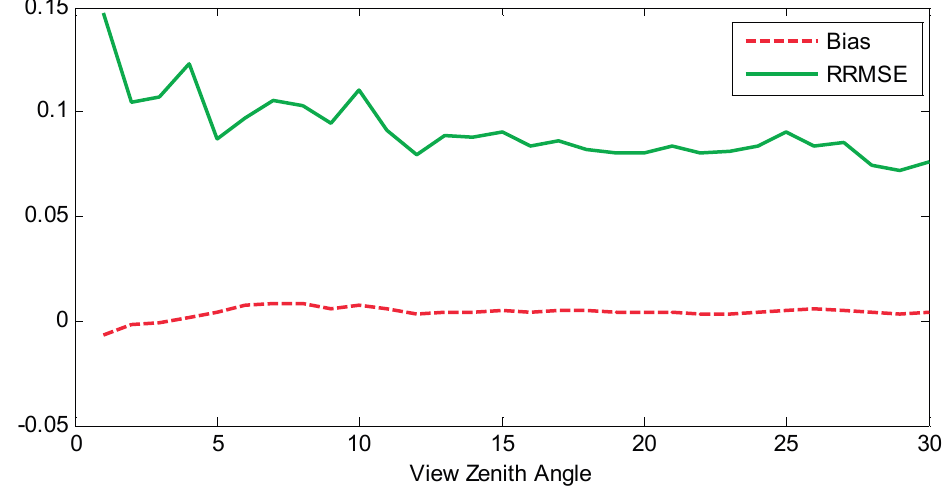
Figure 9. Relationship between HJ white-sky albedo estimation accuracy compared with MODIS product and view zenith angle for forest samples: bias and RRMSE. RRMSE is calculated as the ratio of absolute difference in HJ albedo and MODIS albedo to MODIS